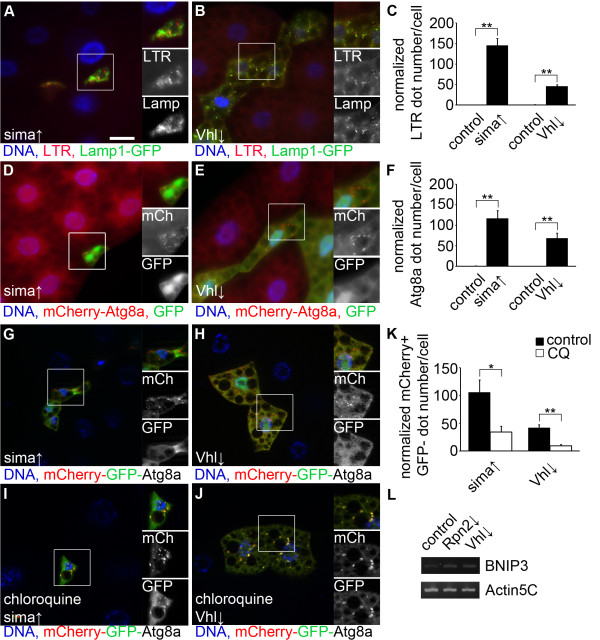
Activation of hypoxia signaling induces autophagy in Drosophila. A-C) Overexpression of the Drosophila HIF-1α ortholog sima (A) or depletion of Vhl(B) induces the formation of autolysosomes positive for both Lamp1-GFP and LTR in fat body cell clones in well-fed larvae. Quantification of data is shown in panel C. Statistically significant differences are marked (u test, n = 6 per genotype, ** P < 0.01), and error bars denote standard error. D-F) Overexpression of sima (D) or knockdown of Vhl(E) promotes the formation of punctate mCherry-Atg8a in fat body cell clones marked by GFP-nls (nuclear localization sequence) in well-fed larvae. Quantification of data is shown in panel F. Statistically significant differences are marked (u test, n = 6 per genotype, ** P < 0.01), and error bars denote standard error. G-J) Overexpression of sima (G) or depletion of Vhl(H) leads to formation of dots that are mostly positive for mCherry with the mCherry-GFP-Atg8a reporter. Chloroquine treatment blocks the autolysosomal quenching of GFP, as puncta are now positive for both mCherry and GFP in cells overexpressing sima (I) or Vhl RNAi (J). K) Quantification of data from panels G-J. Statistically significant differences are marked (u or t test, n = 5-8 per genotype, ** P < 0.01, * P < 0.05), and error bars denote standard error. L) RT-PCR analyses show that the transcription of BNIP3 is upregulated in both Vhl and Rpn2 RNAi samples relative to controls. Boxed areas in A, B, D, E, G-J are shown enlarged. Scale bar in A equals 20 μm for A, B, D, E, G-J.